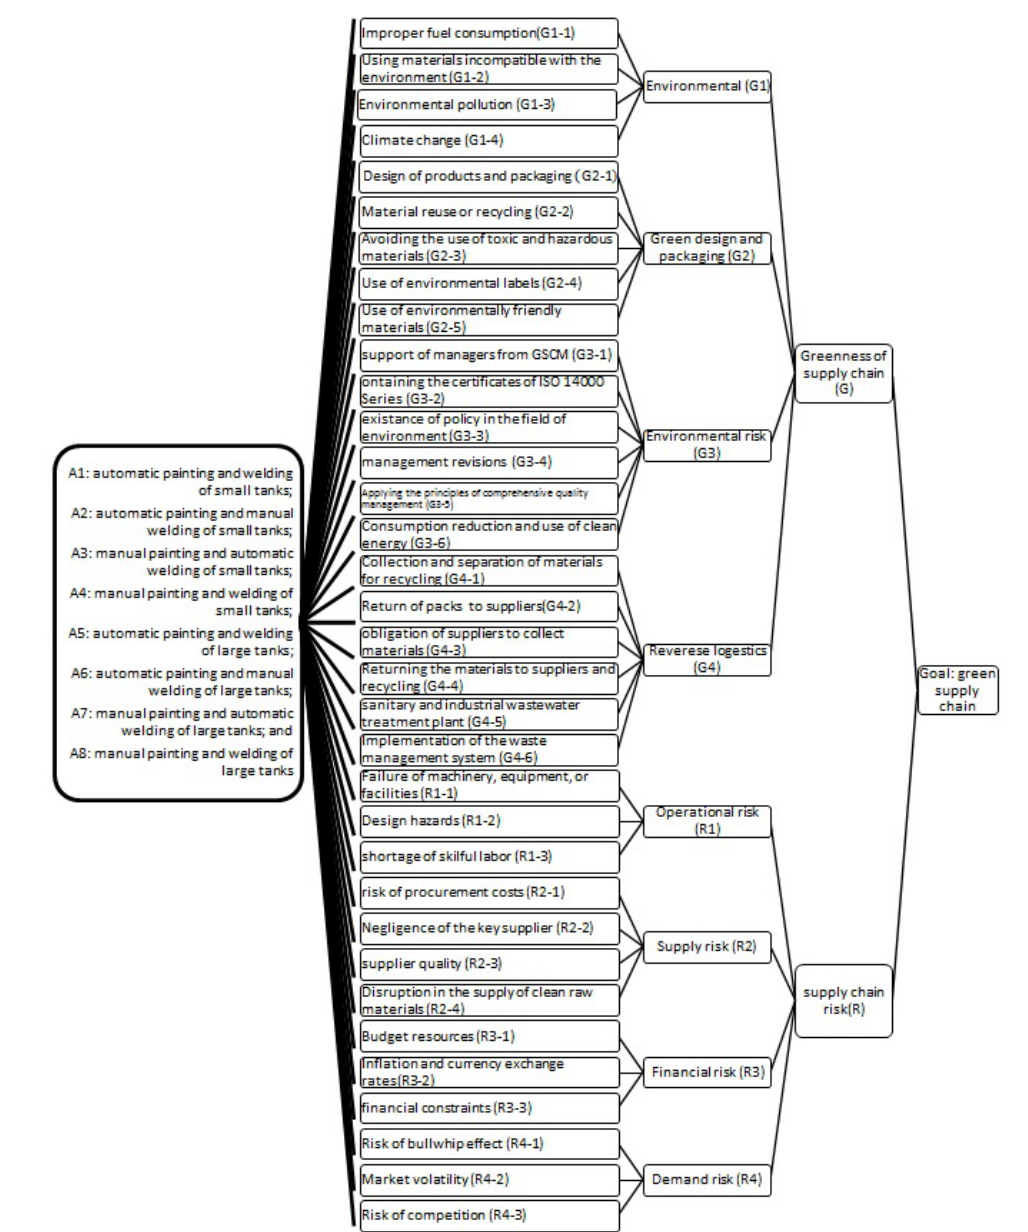
Figure 4. Mapping the relationship of the goal with indicators, sub-indicators, and